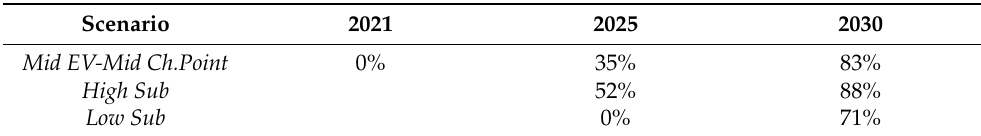
Table 16. Share of charging stations deployed by the private sector in the total available charging stations per time